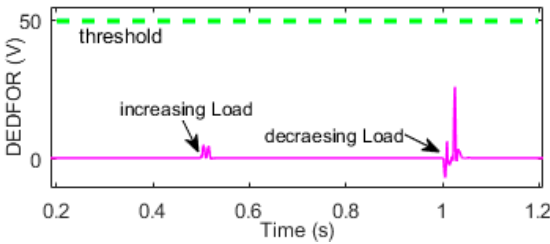
Figure 12. Case 5: Output of the proposed DEDFOR filter under load changes.